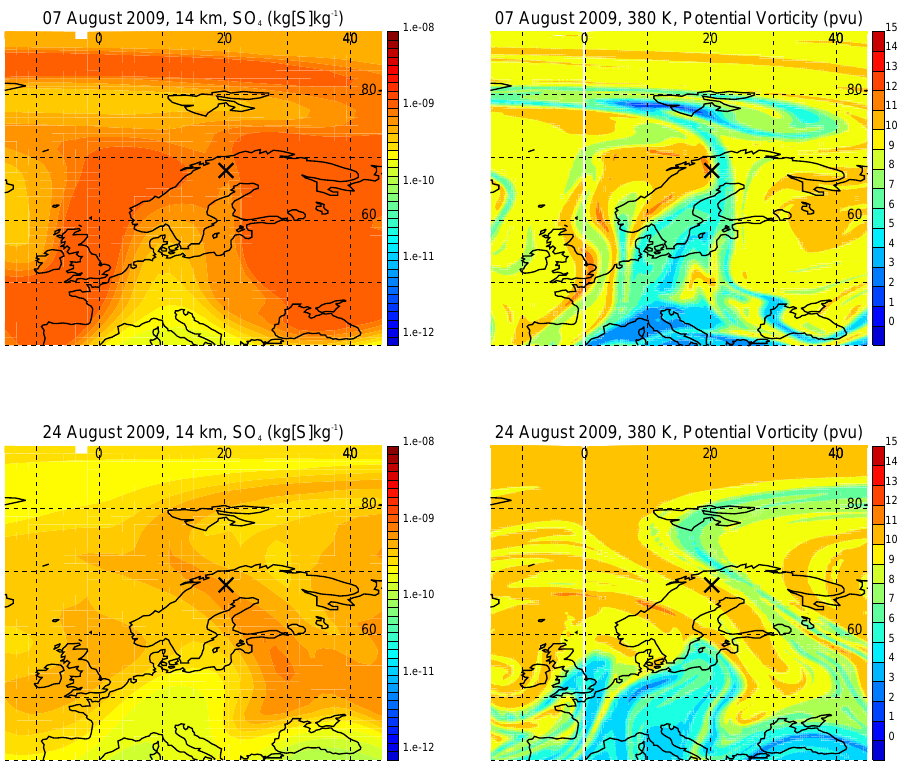
Fig. 10. HadGEM2 sulphur mass in kg[S]/kg[air] at 14 km (left) and potential vorticity (pvu) at 380 K from the MIMOSA model (right) on 7 (top) and 24 (bottom) August 2009.